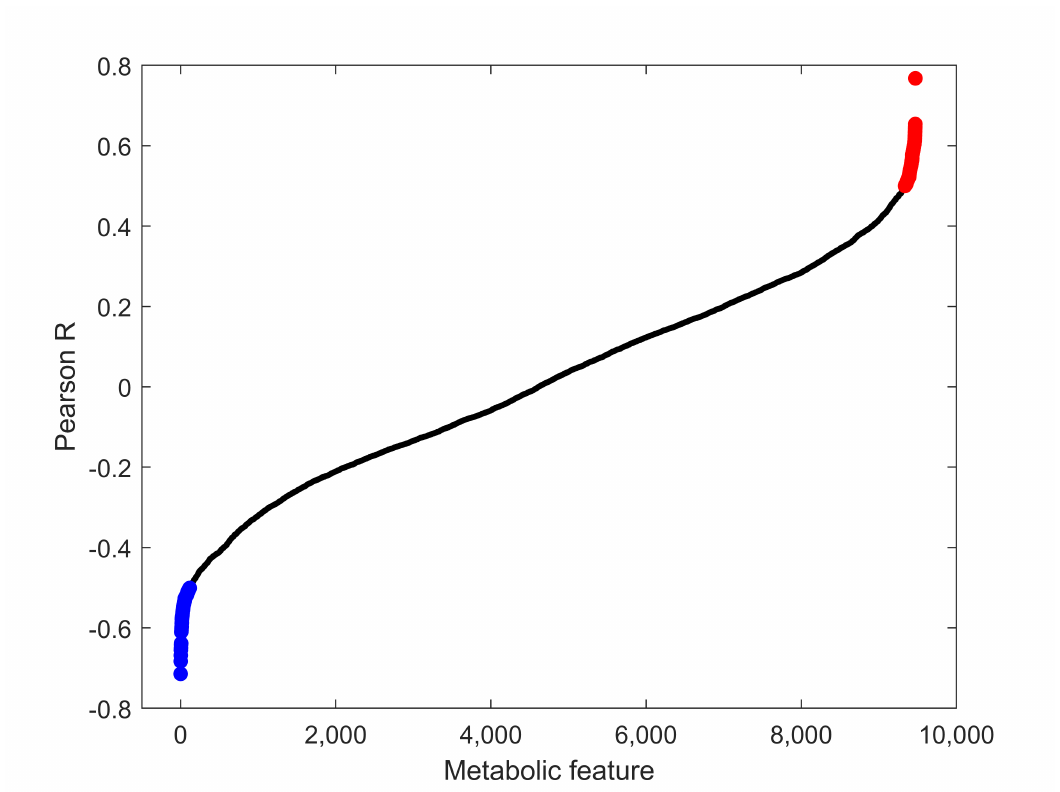
Figure 4. Pearson correlation coefficients between metabolic features and FTOE. Blue: features with p -values < 0.05 and correlation coefficients < − 0.5; red: features with p -values < 0.05 and correlation coefficients > 0.5; black: all remaining